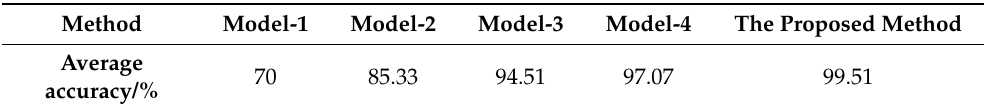
Table 8. Feeder detection results of different methods of superimposing 10 dB noise under asyn- chronous